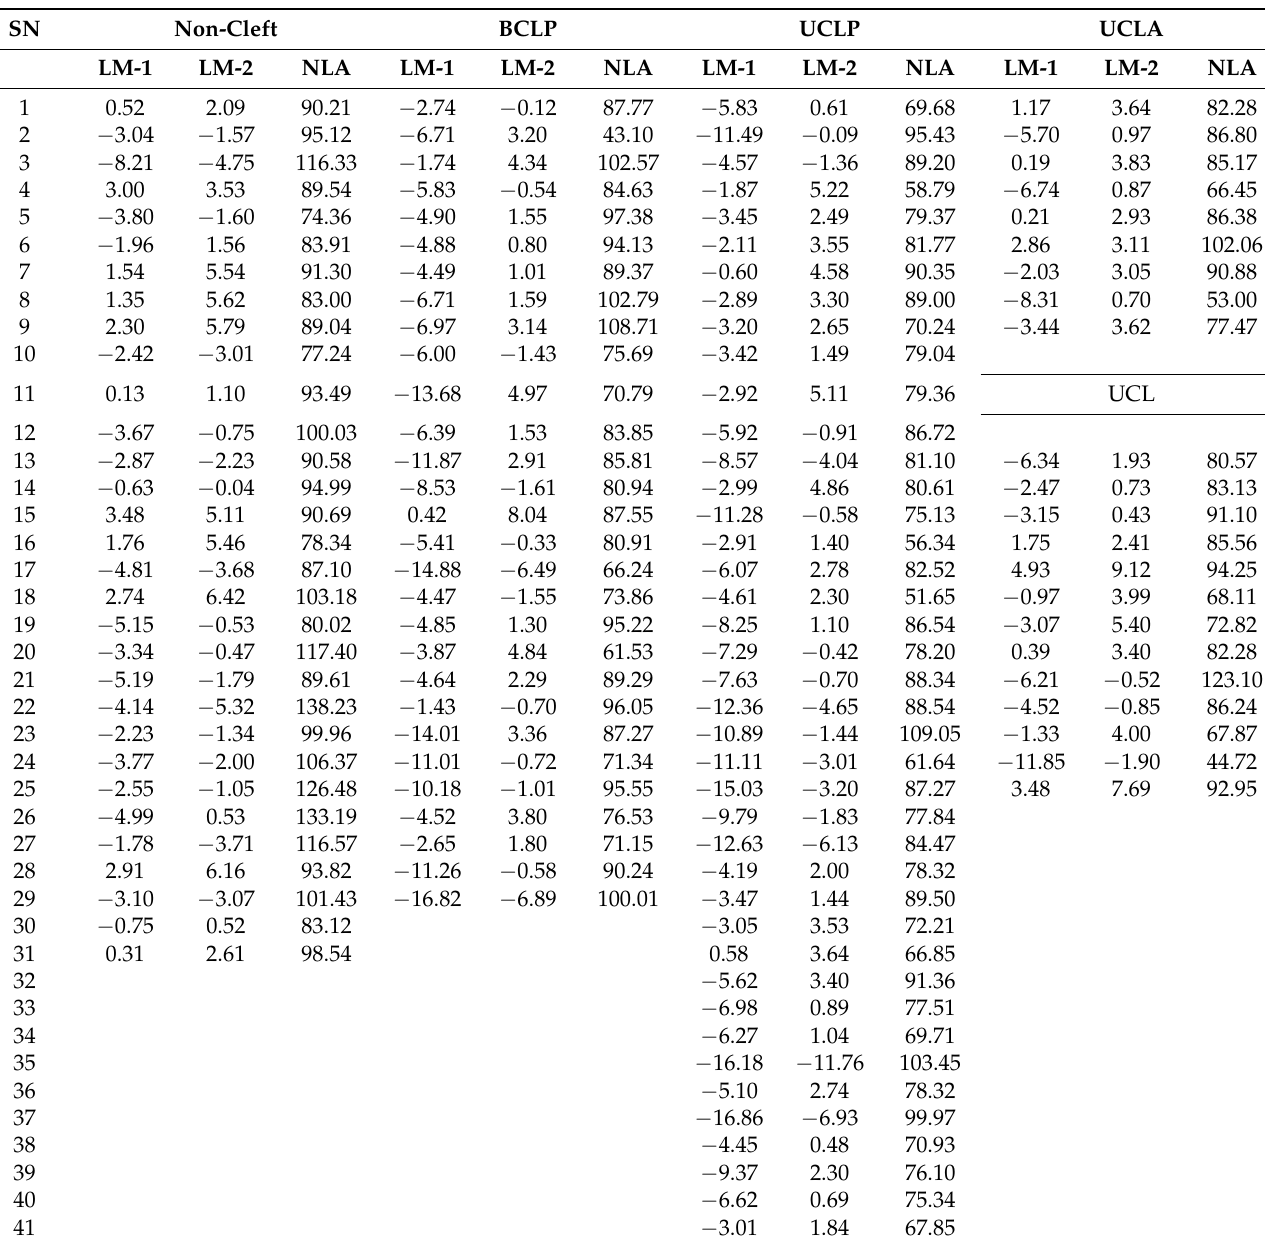
Table 2. Measured data for Upper lip to E plane (LM-1), Lower lip to E plane (LM-2) and Nasolabial angle (NLA) of non-cleft, unilateral cleft lip and palate (UCLP), bilateral cleft lip and palate (BCLP), unilateral cleft lip and alveolus (UCLA), and unilateral cleft lip (UCL) (N = 123, Non-cleft = 31, BCLP = 29, UCLP = 41, UCLA = 9, and UCL =